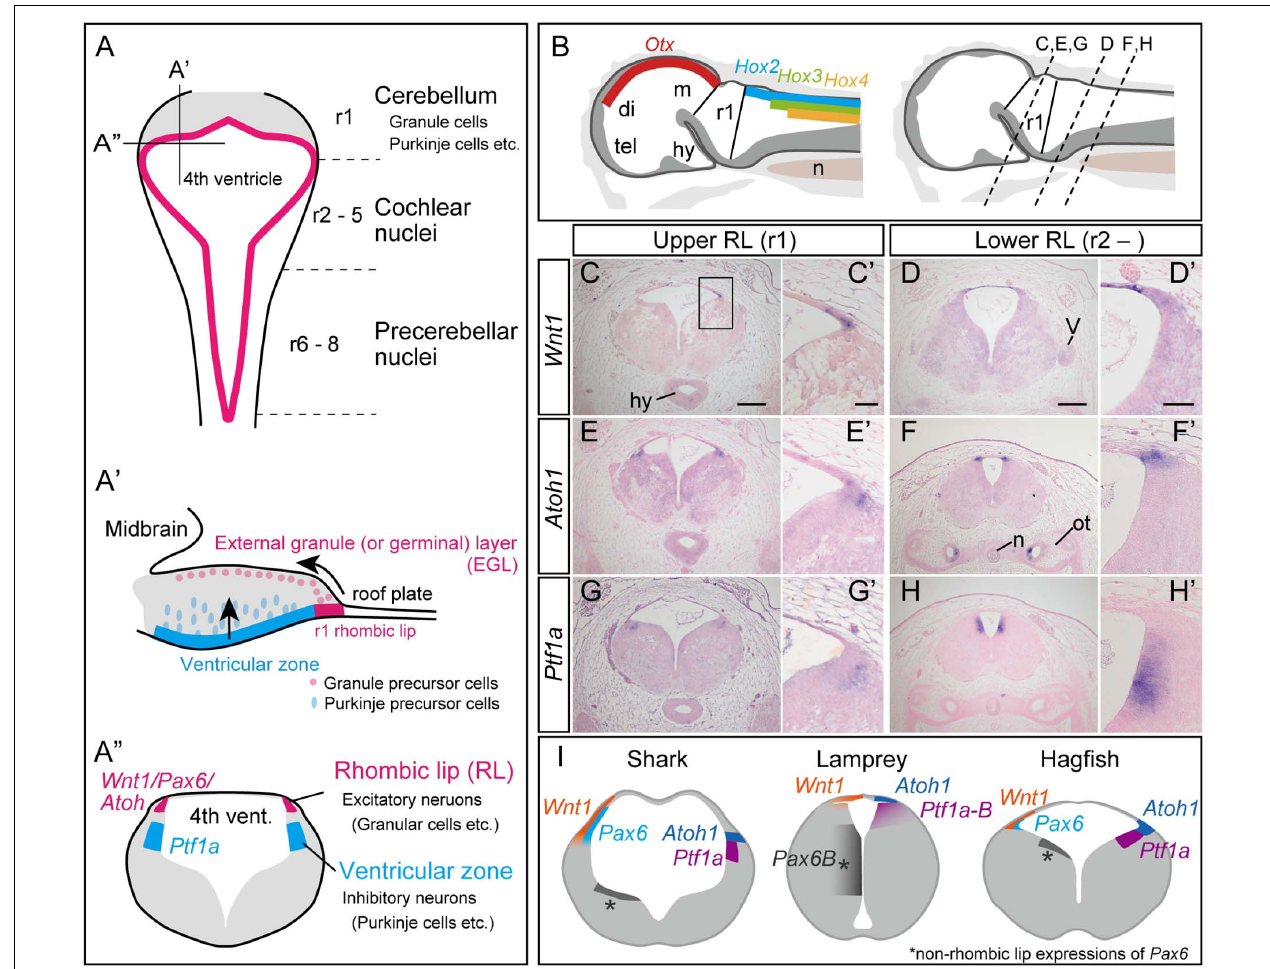
FIGURE 1 | Development of the cerebellum in mammals, based on Fujiyama et al., 2009 (A) . (A) Dorsal view of the rhombomeres. The rhombomere 1 (r1) gives rise to the cerebellum, while r2–8 generates the cochlear nuclei and precerebellar nuclei. (A’) Sagittal view of the rhombomere 1. Granule precursor cells, generated in the r1 rhombic lip, migrate tangentially to form the external germinal layer (EGL). The Purkinje precursor cells originating from the ventricular zone secrete Shh, which is involved in the proliferation of the granule cells. The granule cells in EGL then migrate ventrally to form the granular layer. (A”) Transverse view of rhombomere 1 showing the rhombic lip as the source for excitatory neurons, and the ventricular zone where the inhibitory neurons arise. (B–H) Upper and lower rhombic lip gene expression patterns in the hagfish, E. burgeri . (B) Illustration of a sagittal section of the anterior part of a stage 53 embryo. (left) Rhombomere 1 (Upper rhombic lip) is identified as a negative region of both Otx and Hox genes (Oisi et al., 2013; Pascual-Anaya et al., 2018). (right) Anterior-posterior level of transverse sections shown in (C–H) are indicated in a sagittal illustration. (C–H) Section in situ hybridizations for hagfish Wnt1 , Atoh1 and Ptf1a genes showing their expression patterns in r1 (C,E,G) and posterior to r1 (D,F,H) . (C’–H’) Higher magnification images of the rhombic lip expression patterns shown in (C–H) . (I) Comparison of the upper rhombic lip gene expression patterns in the shark ( S. torazame ), lamprey ( L. camtschaticum ), and hagfish ( E. burgeri ) based on Sugahara et al. (2017) and